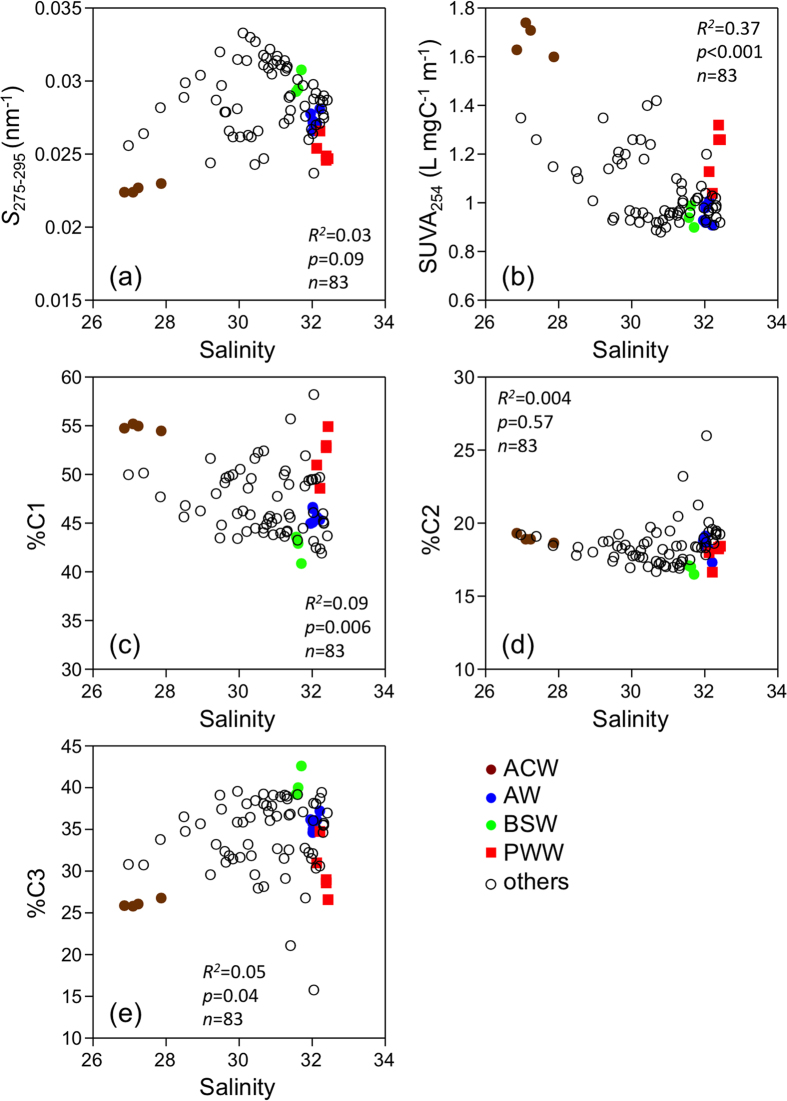
Property-property plots between salinity and (a) S275–295, (b) SUVA254, (c) % C1, (d) %C2, and (e) %C3.